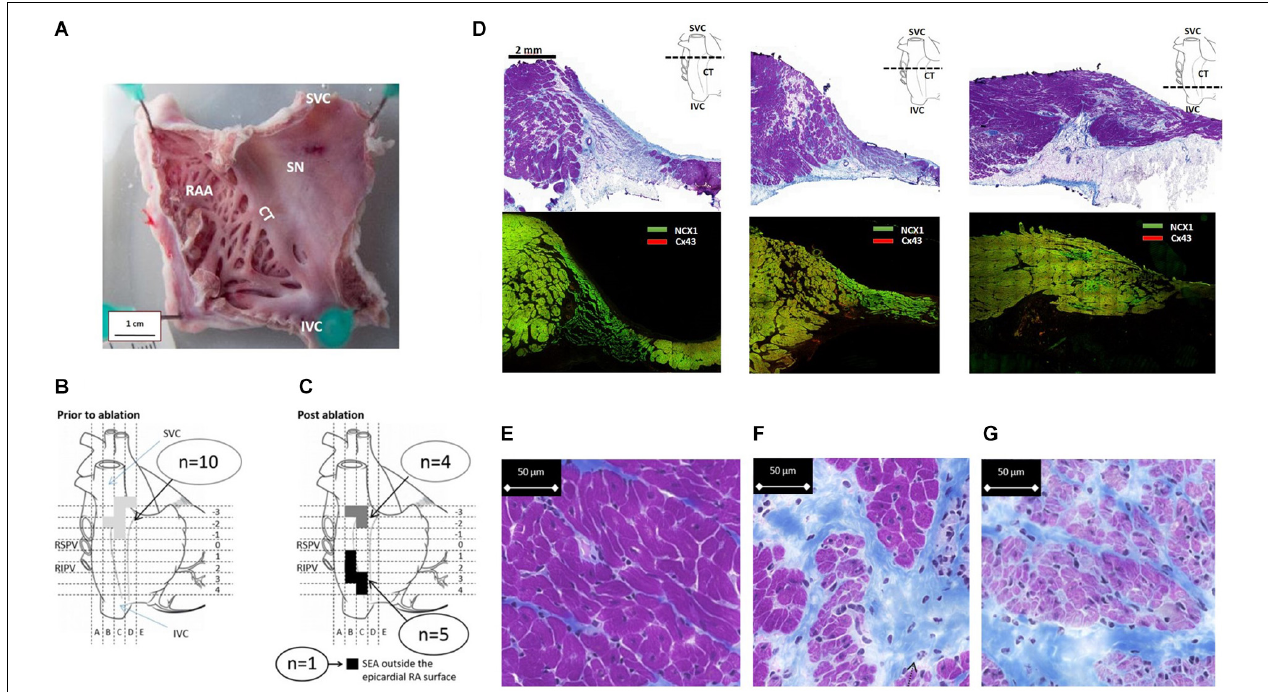
FIGURE 1 | Functional evaluation of the SAP region and the SAN in goats. (A) Fresh preparation of the posterior wall of the right atrium (RA) from a control goat. CT, crista terminalis; SAN, sinus node; IVC, inferior vena cava; SVC, superior vena cava. Schematic diagrams (B,C) depict the locations of the site of earliest activation during mapping and ablation experiments. (B) Location of the site of earliest activation (SEA) prior to ablation ( n = 10) is represented by the shaded area (light gray). (C) After ablation, the shaded squares correspond to regions of the RA where each individual SEA shifted to. Two well-separated areas are defined: one cluster is close to the IVC/RA junction (black), while the second cluster remained close to the RA/SVC junction (dark gray); n = 6 are shown; one SEA was outside the accessible epicardial RA surface and is therefore presumed to be either on the interatrial septum or left atrium. (D) Cross-sections of the SAN and PNA, taken perpendicular to the CT at the levels displayed by the dashed line in the schematic. The top row shows Masson’s trichrome (connective tissue stains royal blue, the cytoplasm pink, and the nuclei dark blue). The area of the SAN is identifiable by its pale appearance. The SAN occupies the full thickness of the intercaval region in the superior sections. The PNA appears as a loosely packed bundle, which is localized between the SAN and the working atrial myocardium. The bottom panels in panel (D) shows adjacent sections double labeled for NCX1 protein (green) and Cx43 protein (red); SAN tissue is characterized by the presence of NCX1 but the absence of Cx43 and thus appears bight green on these images due to the absence of red signal from Cx43. Regions of nodal tissue can be identified in all sections including the most inferior part of tissue. (E–G) High-magnification images of Masson’s trichrome-stained atrium (E) , PNA (F) , and SAN (G) . The SAN cells are smaller, paler (stained purple), and embedded in a rich connective tissue (royal blue) compared to the atrial myocardial